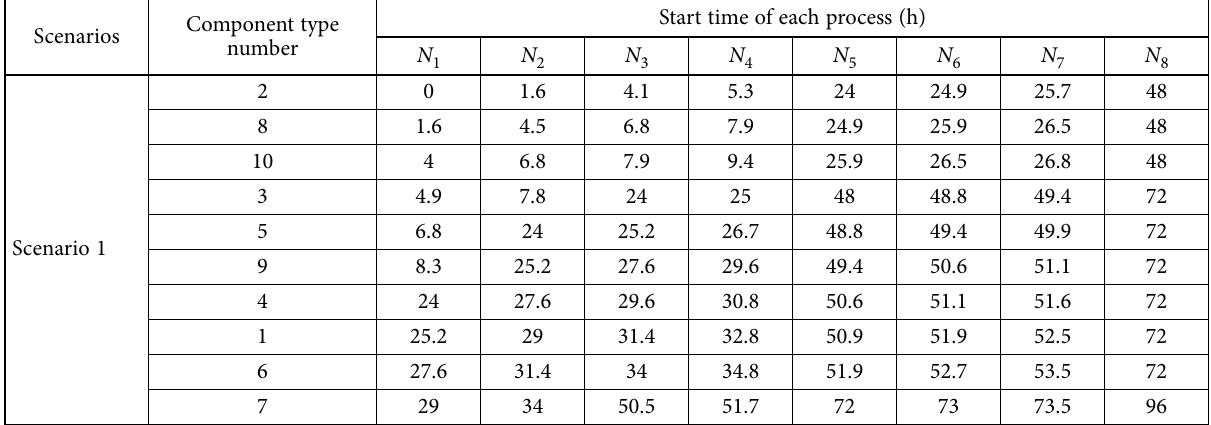
Table 4. Start time of each process for the optimal scheduling plan ( g = 1)